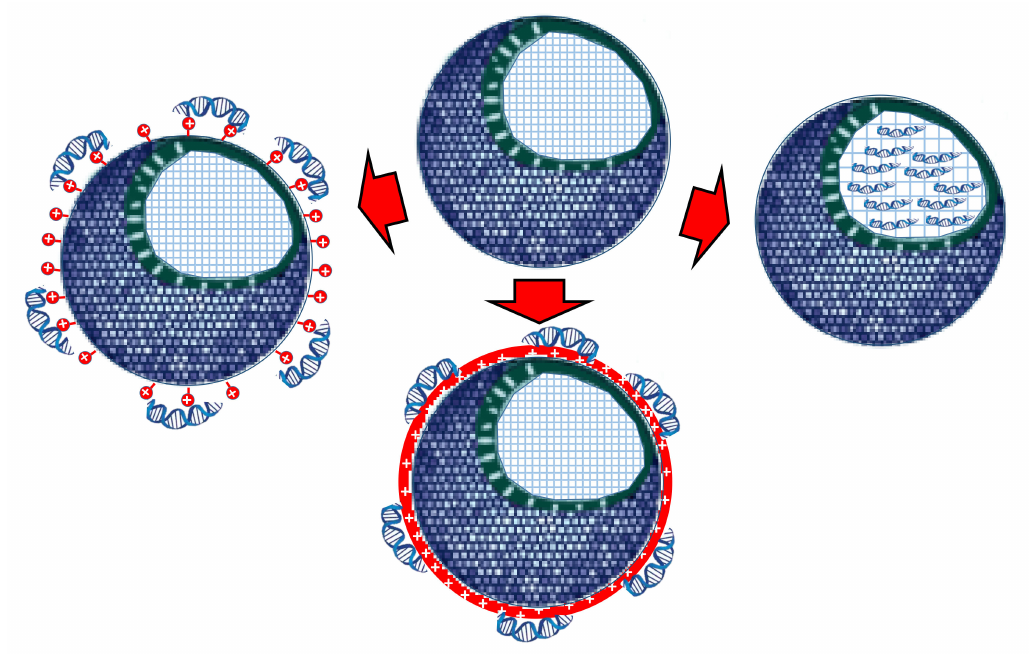
Figure 2. Schematic representation of di ff erent strategies to carry nucleic acids in MSNs: Nucleic acid delivery by surface-functionalized MSNs ( left ), nucleic acid delivery by polycation-coated MSNs ( center ) and nucleic acid delivery within MSN pores ( right